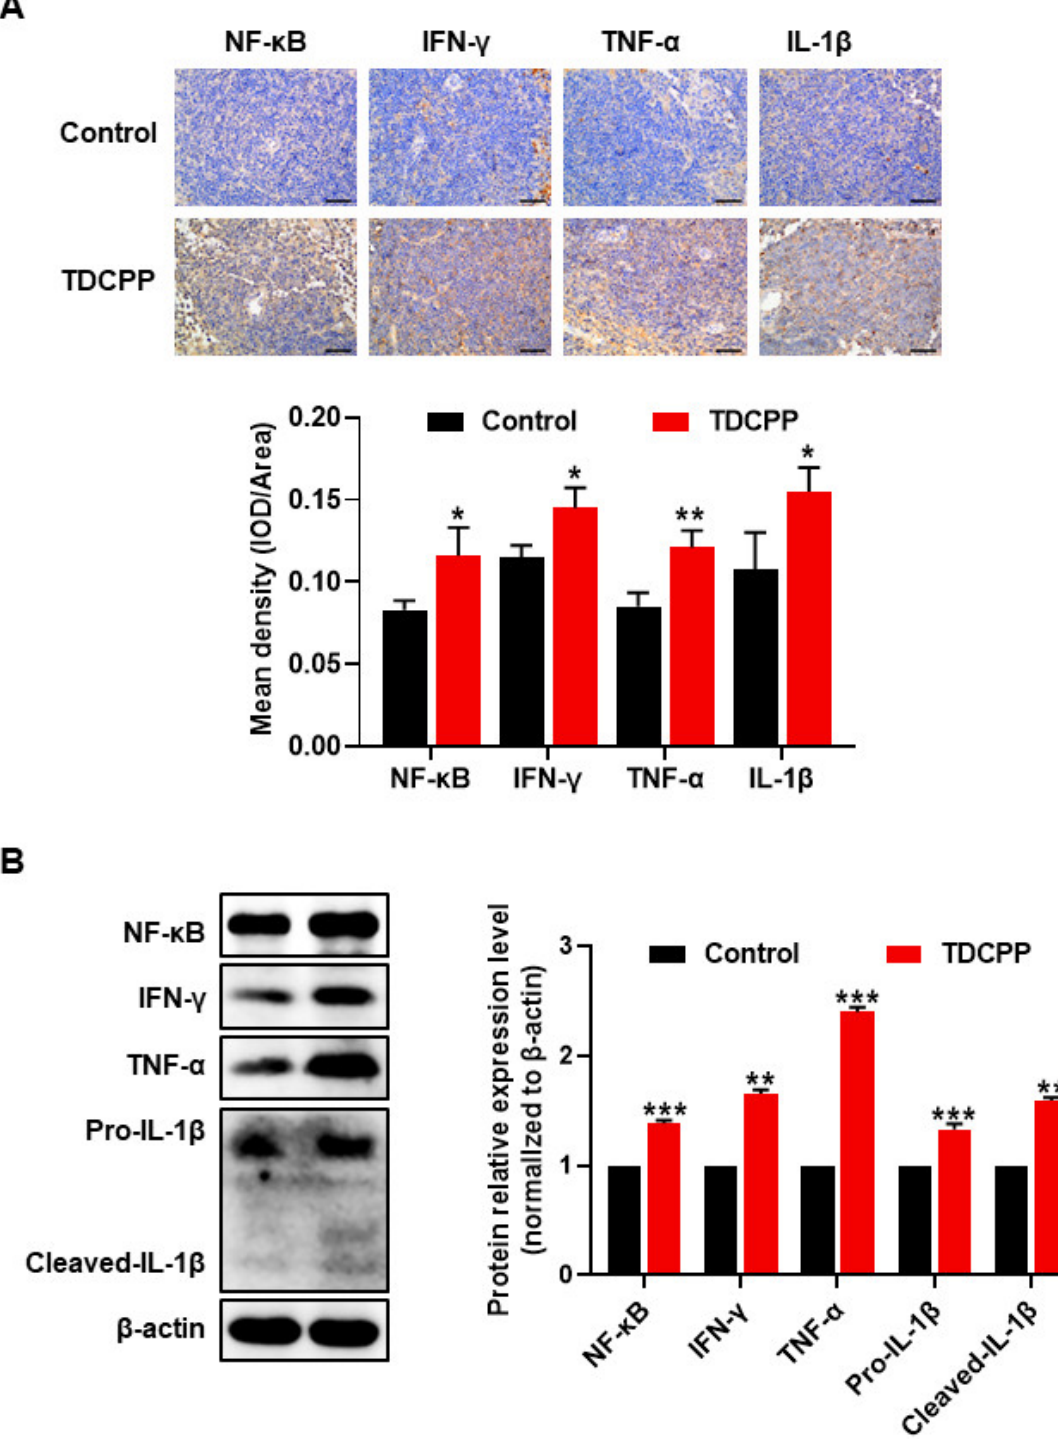
Figure 2. Exposure to TDCPP activated the NF-kB pathway and induced inflammation in the spleen. ( A ) To explore the changes in NF-κB signaling in the inflammatory response to TDCPP-induced splenic tissue injury, NF-κB/IFN-γ/TNF-α/IL-1β expression and tissue localization were detected in mice spleen using IHC. ( B ) The protein expressions of NF-κB/IFN-γ/TNF-α/IL-1β were detected using Western blotting. * p < 0.05, ** p < 0.01, *** p < 0.001, compared with control group.